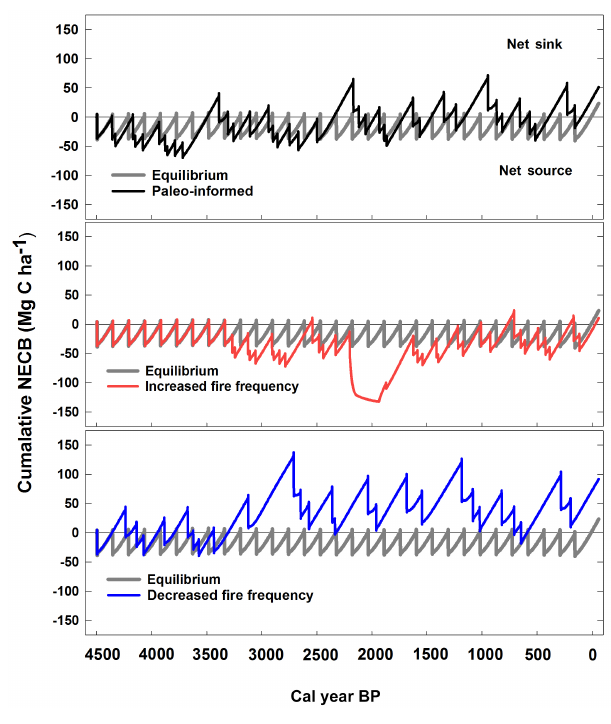
Figure 4. Trends in cumulative NECB over time for the paleo- informed, increased fire frequency, and decreased fire frequency scenarios compared to equilibrium over the last 4561 years. Posi- tive numbers indicate a cumulative net sink, while negative numbers indicate a cumulative net